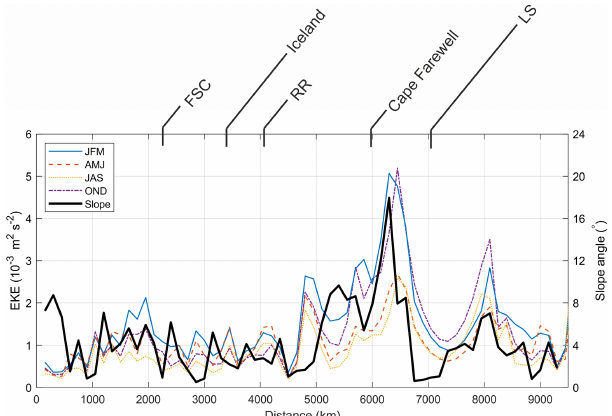
Figure 11. Angle of continental slope (black) compared to EKE by region. Key locations around the boundary are labelled as in Fig. 3; note that the x axis excludes the 47 ◦ N